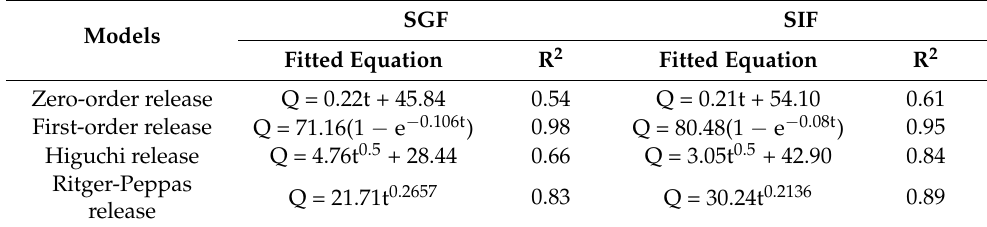
Table 9. Release behavior fitting results of BEO microcapsules in SGF and SIF.